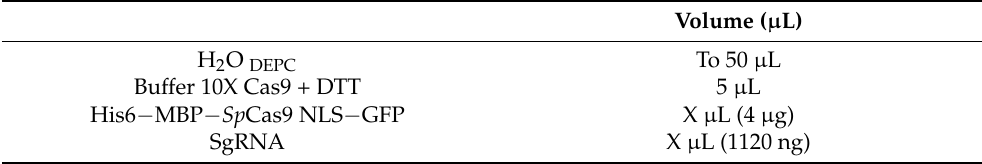
Table 3. Nuclease activity